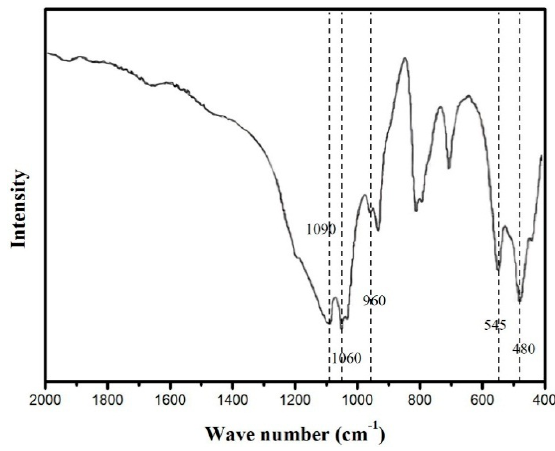
Figure 5. Infrared spectrum of MZTC-2.5.